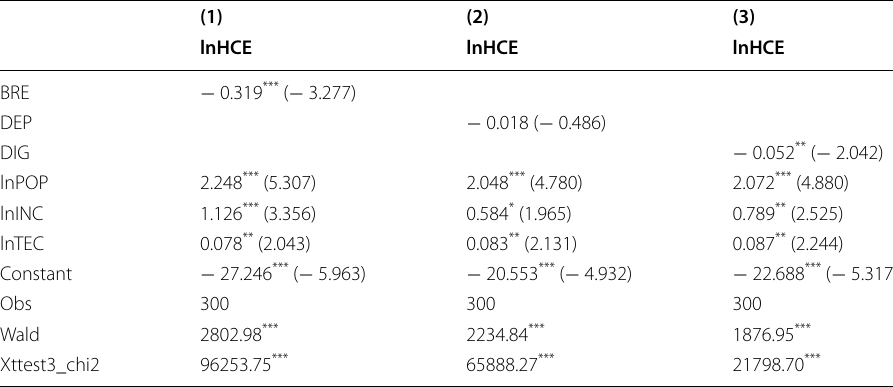
The values in parentheses represent the t-statistics * , ** , *** imply the significance at the 10%, 5%, and 1% levels,